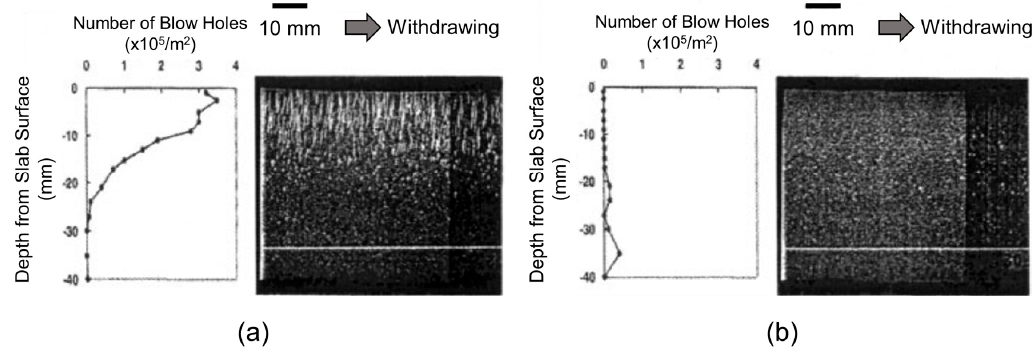
Figure 24. Subsurface-entrapped bubble defects in steel slabs ( a ) without and ( b ) with EMRS [32].